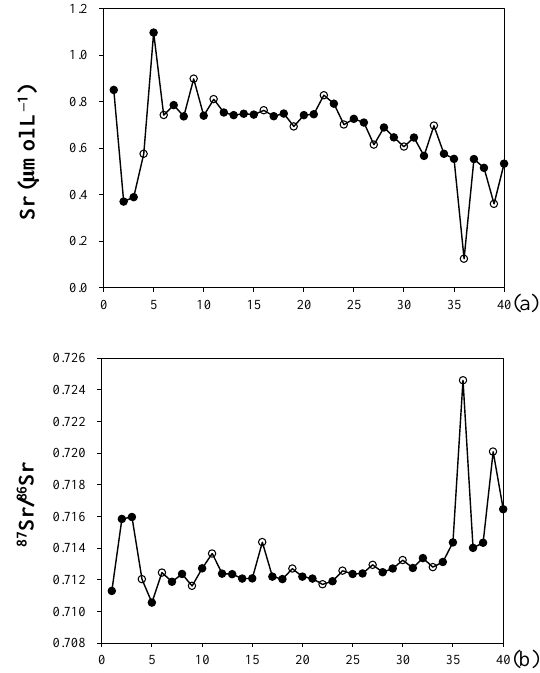
Fig. 7. Spatial variations of the Sr concentrations (a) and the 87 Sr / 86 Sr ratios (b) in the Guijiang River. The filled and open circles represent the samples in the mainstreams and tributaries,